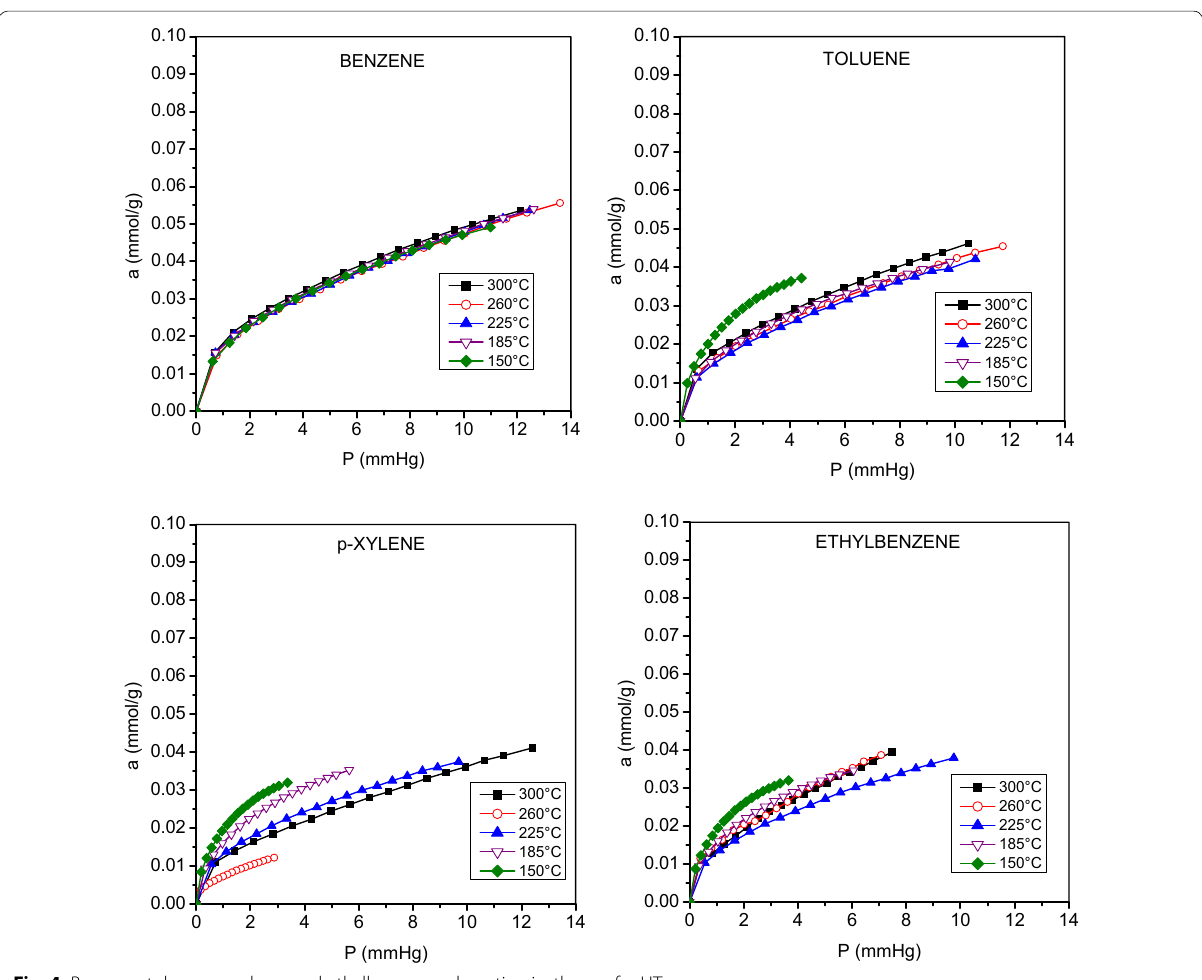
Fig. 4 Benzene, toluene, p ‑xylene, and ethylbenzene adsorption isotherms for HT